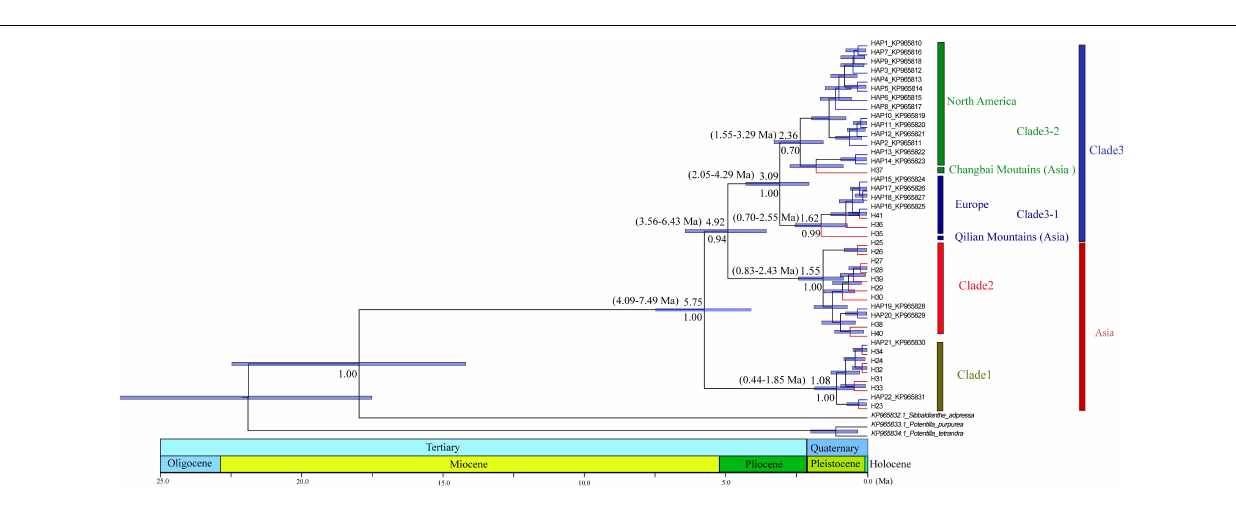
FIGURE 3 | Phylogenetic relationships among haplotypes. Numbers below branches denote posterior probability. Number above nodes indicates the estimated time to the most recent common ancestor. The haplotypes with blue color branches represent the haplotypes from Allen et al.